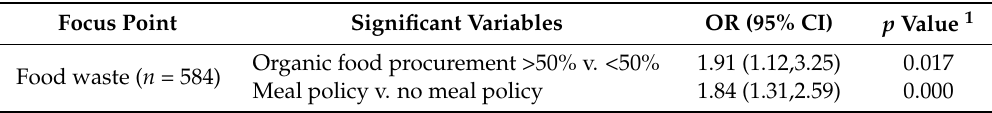
Table 6. Variables significantly ( p ≤ 0.05) associated with a very high focus on food waste reduction.